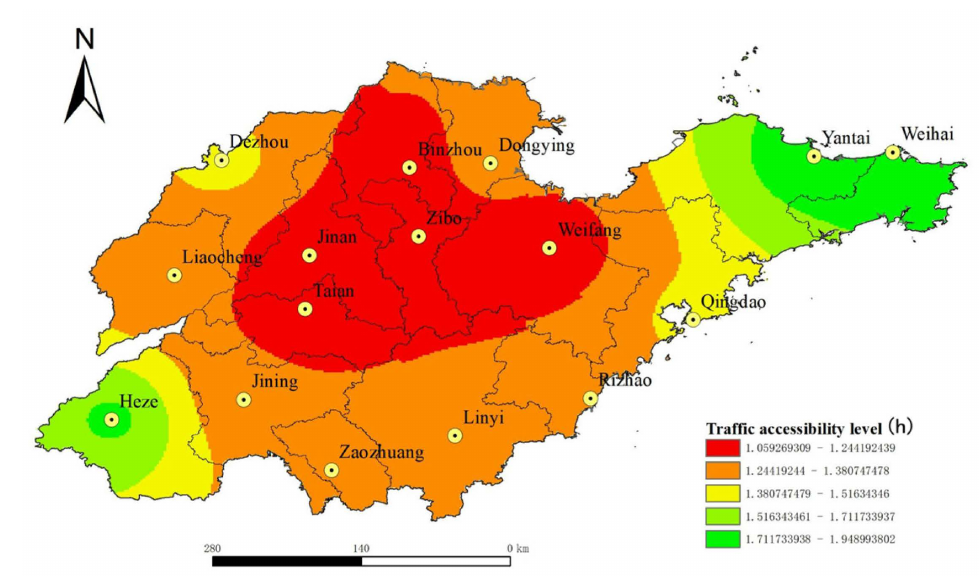
Figure 5. Prediction of spatial distribution of land traffic accessibility in Shandong Province, China, in